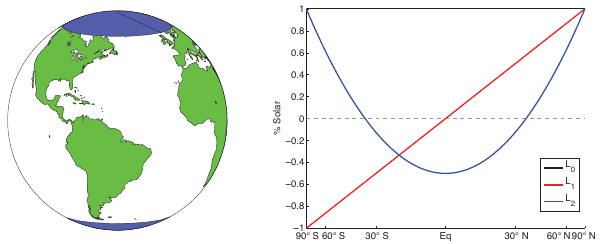
Figure 2. The degrees of freedom that were modified in the two cases considered here, referred to as 2 × 2 (left panel) and 3 × 3 (right panel). In the 2 × 2 case, Arctic and Antarctic insolation (shaded regions) are modified to minimize changes in Arctic tem- perature and the latitude of the precipitation centroid due to increas- ing CO 2 (see Sect. 2 for details). In the 3 × 3 case, the three patterns of insolation reduction illustrated here are modified to minimize changes in global mean temperature, the inter-hemispheric temper- ature gradient, and the Equator-to-pole temperature gradient caused by increasing CO 2 (see Sect.